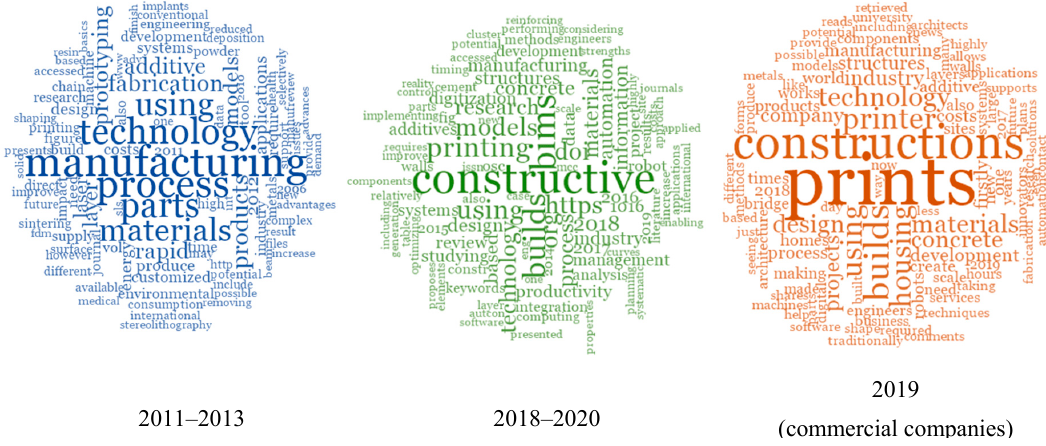
Figure 12. Dominated concepts and main concerns within the literature or the industry.